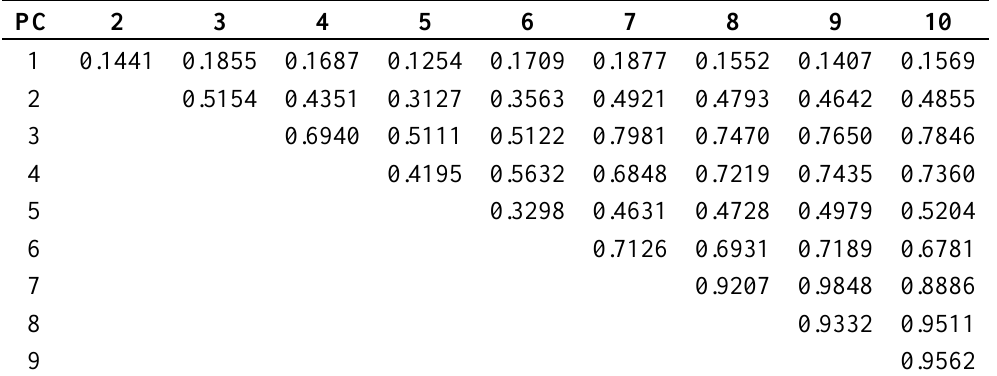
Table 1. The dispersion ratio when any two eigenvectors comprise a lower-dimensional